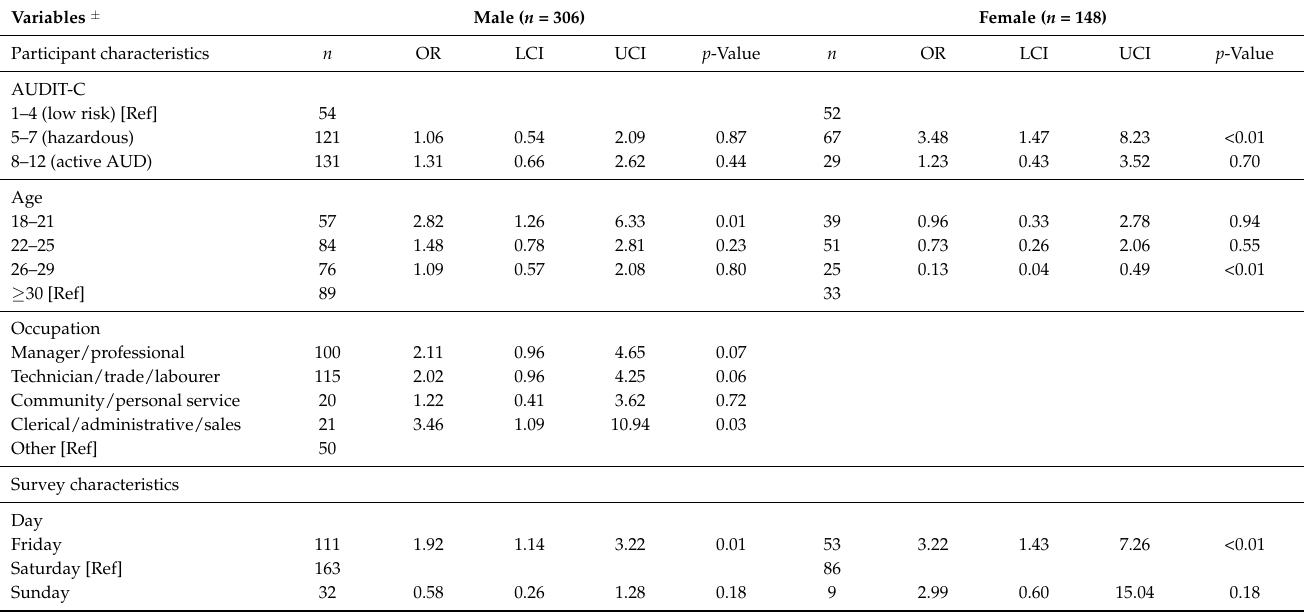
Table 2. Results from two gender-specific logistic regression models: Association between AUDIT-C category and participants’ preferred bar’s closing time (late = 1; standard = 0) adjusting for survey and participant characteristics ±